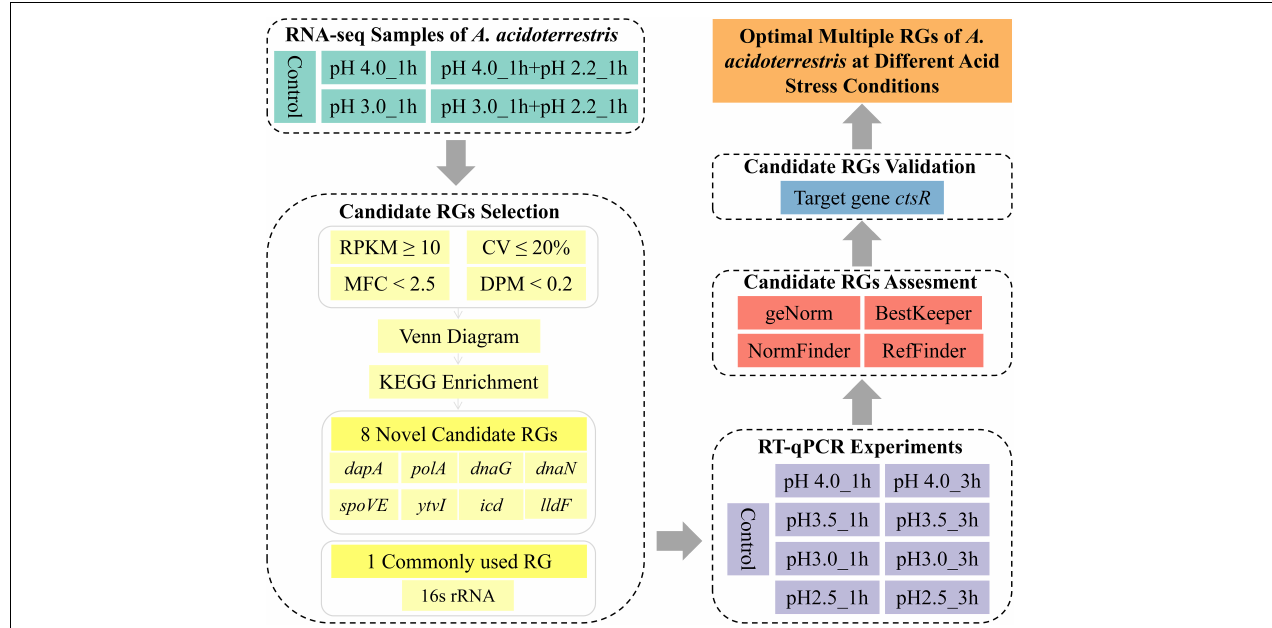
FIGURE 1 | The overall workflow of this